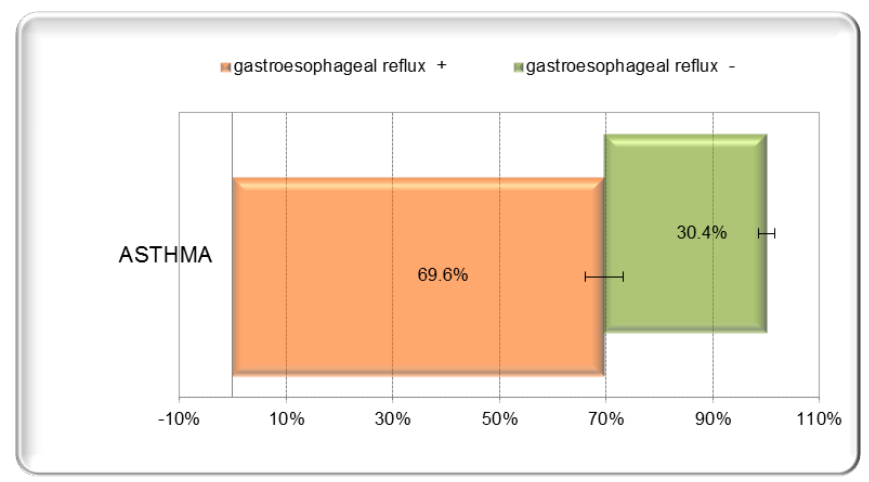
Figure 2. The association of GER with asthma . Table 1. Coefficients and Wald tests for logistic regression.